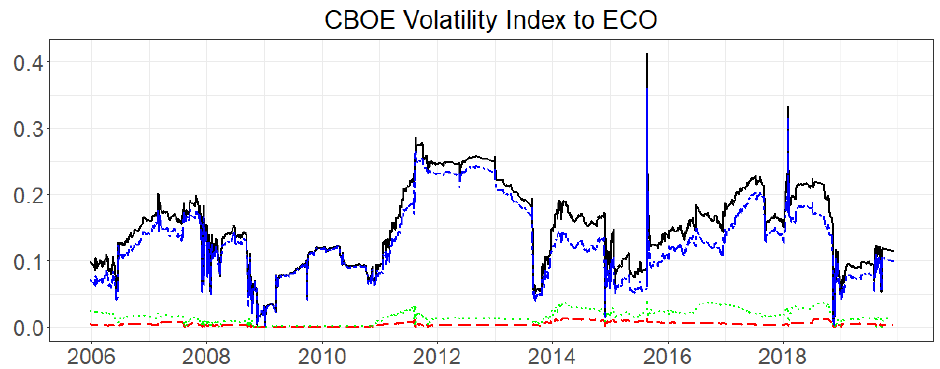
Figure 9. Diebold–Yilmaz [15] directional volatility spillover (pairwise) and Barunik–Krehlik [16] directional volatility spillover (pairwise) in the US. Note: ECO indicates the Wilder Hill Clean Energy Index.